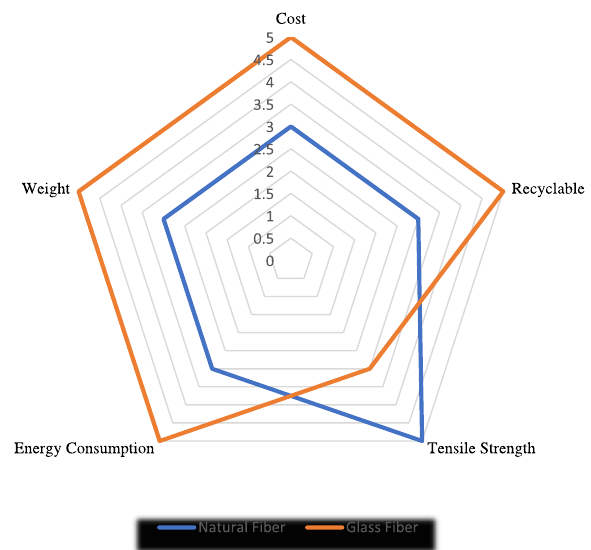
Fig. 5 Properties and limitations. Natural fi ber vs. glass fi ber 54